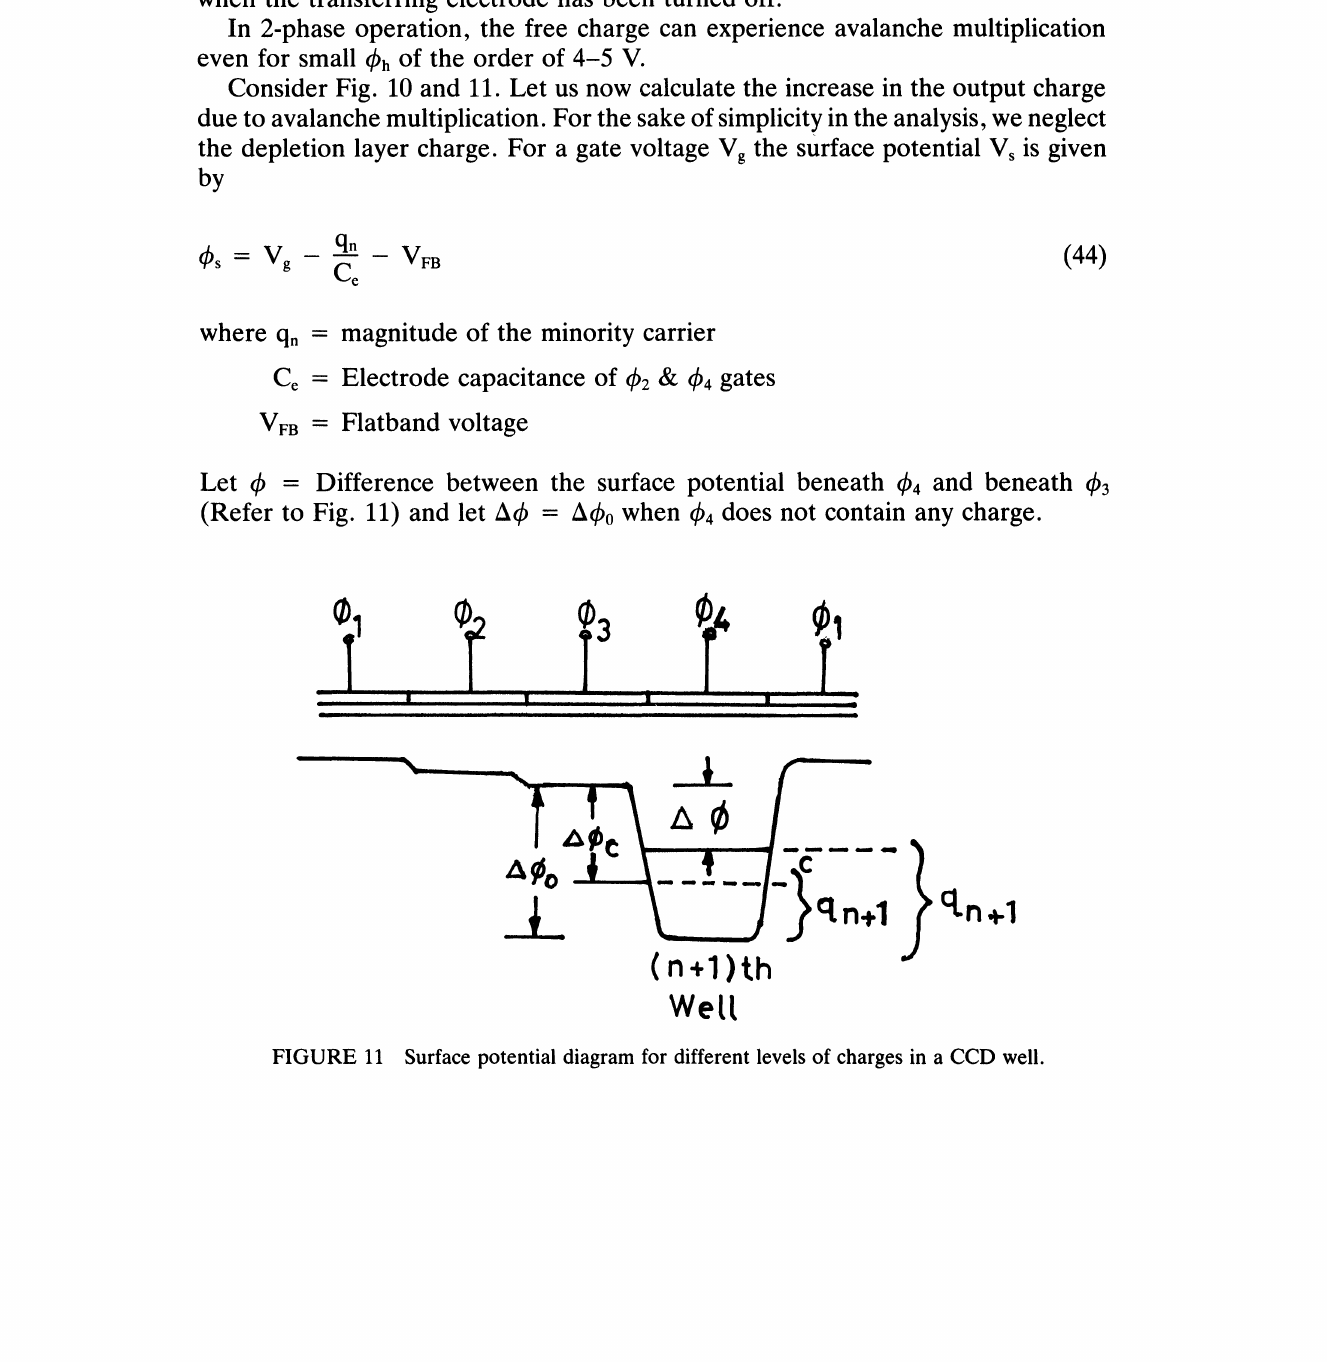
FIGURE 11 Surface potential diagram for different levels of charges in a CCD